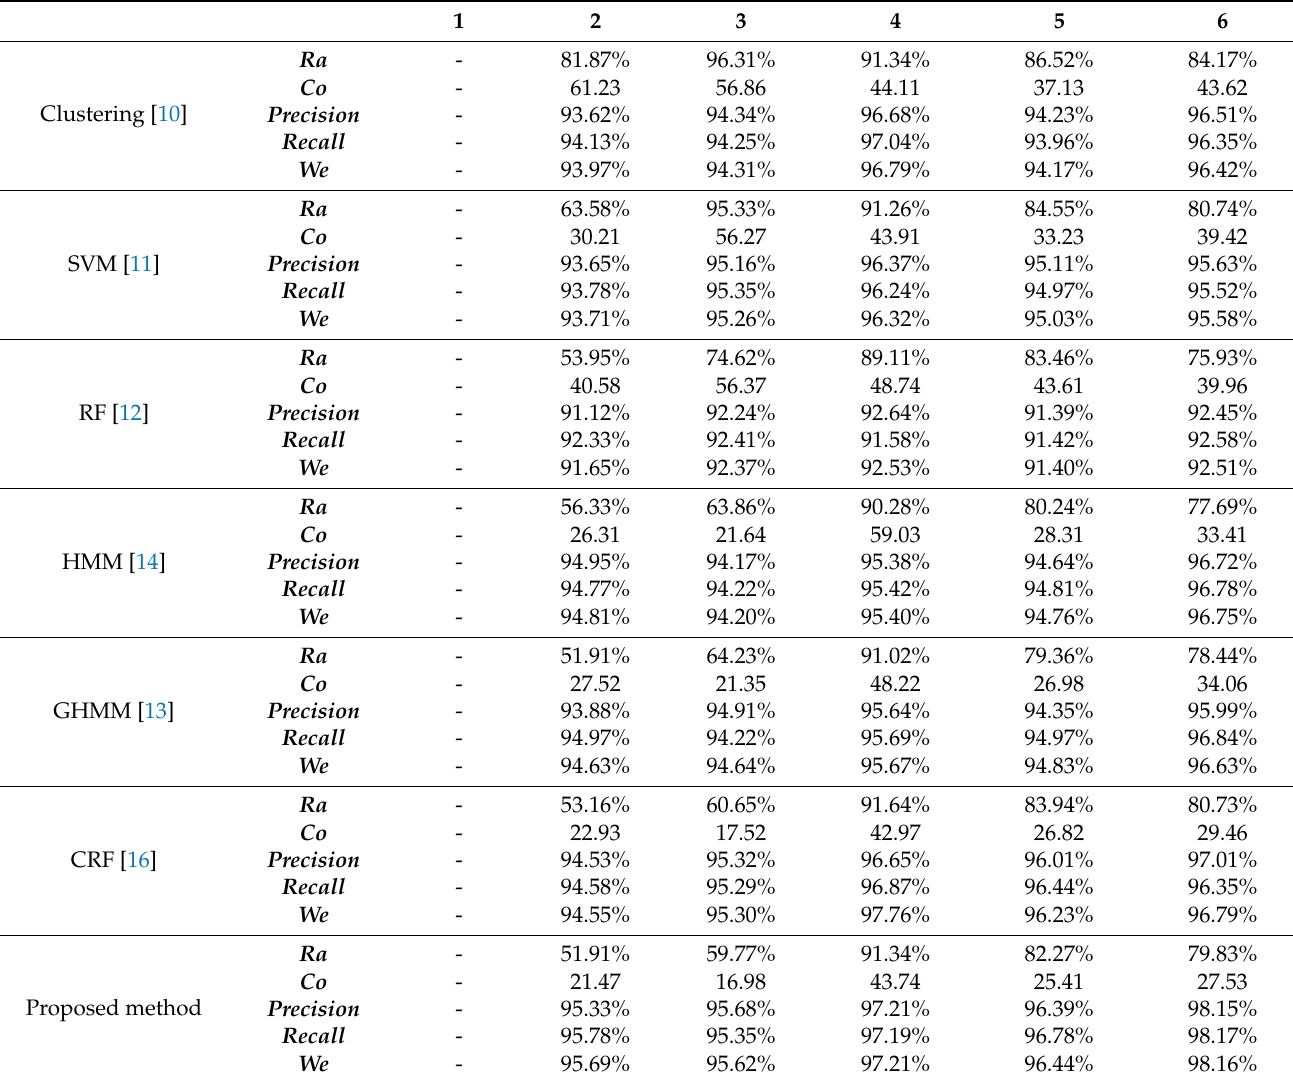
Table 6. Comparison of real images gaze test evaluation